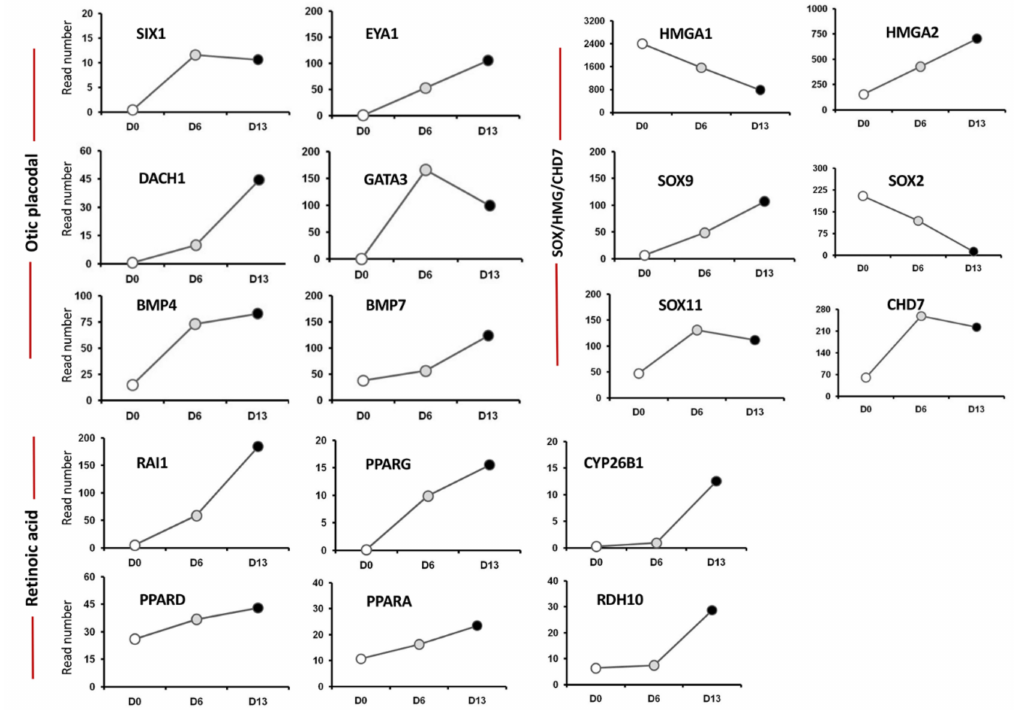
Figure 2. Analysis of cell lineage trajectories by HTS of hiPSCs-derived otic sensory cells. The figure shows read numbers of otic/placodal lineage-specific ( SIX1 , EYA1 , DACH1 , etc.), SOX / HMG / CHD7 ( SOX9 , SOX11 , HMGA2 and CHD7 ) and RA signaling pathway (RAI1, CYP26B1, RDH10, . . . ) gene markers that are gradually enriched during the time course of otic induction at day 6 and day 13 in vitro as compared to undifferentiated hiPSCs at day 0 in